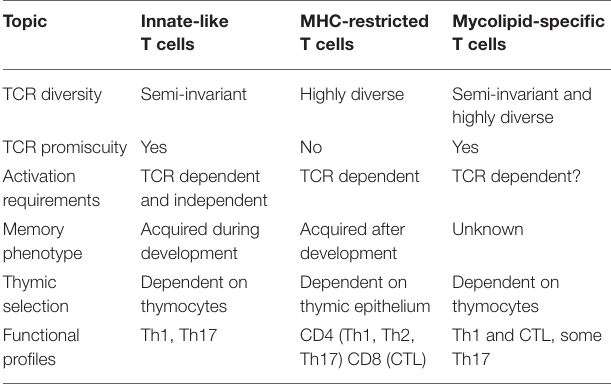
TABLE 1 | Summary of properties exhibited by innate-like, MHC-restricted, and mycolipid-specific T